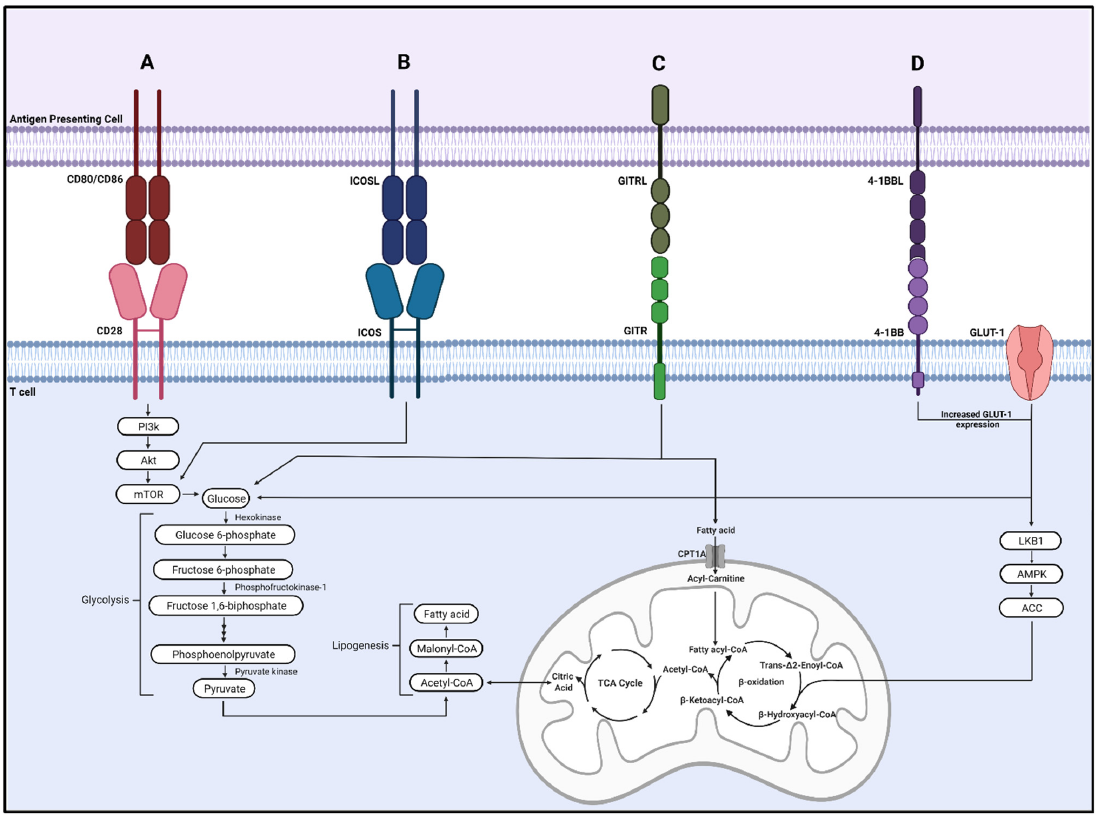
Figure 2. Stimulatory checkpoint proteins regulate metabolic signaling. ( A ) CD28 activation promotes PI3K/Akt/mTORC1 pathway signaling, increasing glycolysis and mitochondrial metabolism. ( B ) ICOS/ICOSL activation increases glucose up- take and metabolism through mTOR activation. ( C ) GITR activation can stimulate the TCA cycle by metabolism lipid, glucose, and other nutrient stores ( D ) 4-1BB activation increases GLUT-1 expression to enhance glycolysis and fatty acid metabolism through LKB1/AMPK/ACC pathway